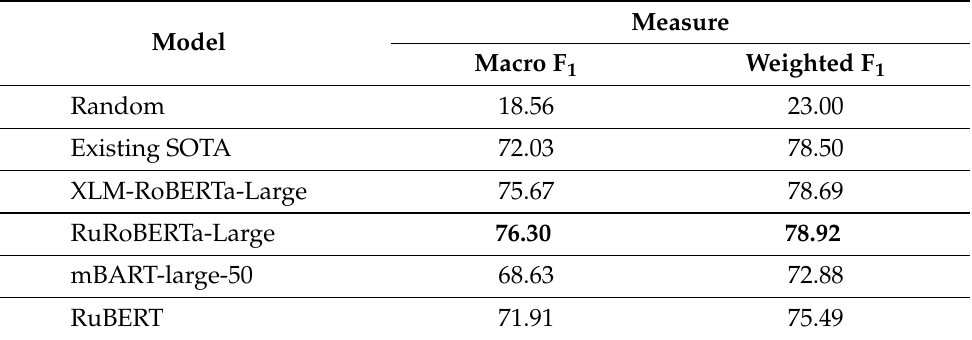
Table 3. Classification results of fine-tuned models. Random represents a random classifier. Weighted F 1 is reported because it was used as the main quality measure in the original paper.